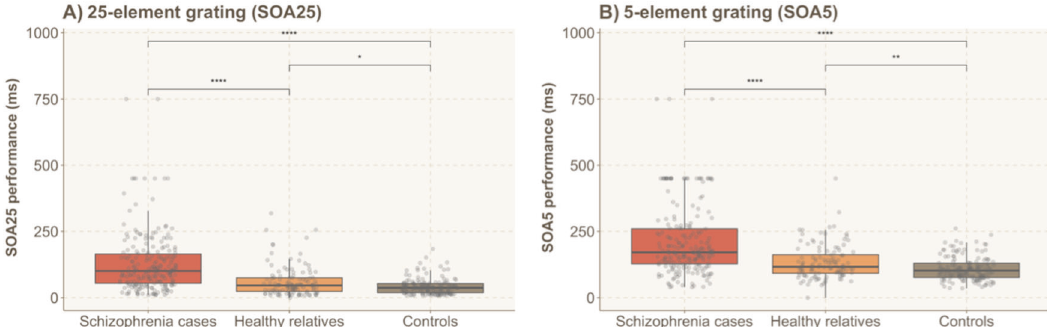
Fig. 2 Threshold SOAs for the 25 and 5 elements grating (SOA 25 and SOA 5, respectively). Patients had longer SOAs compared to their relatives and controls for both the task A with the 25 and B with 5 gratings. Performance of relatives lies between the one of controls and patients. Asterisks indicate statistically signi fi cant differences: * P < 0.05 , ** P ≤ 0.01, ***P ≤ 0.001 , **** P ≤ 0.0001, n.s. not signi fi cant.